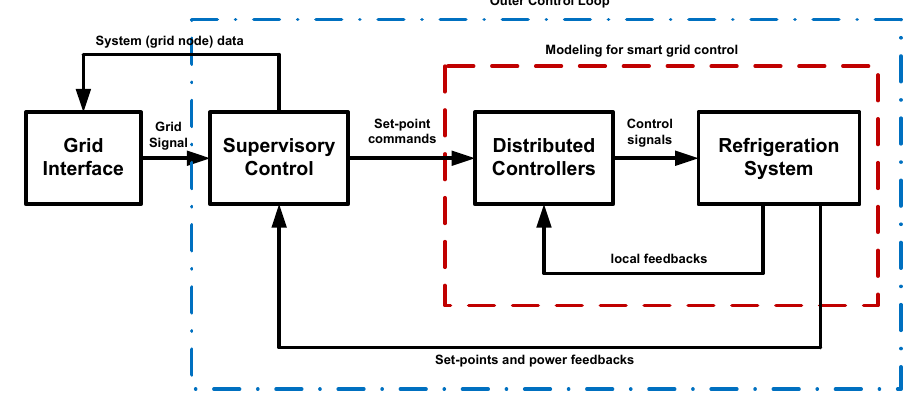
A typical control system structure for connecting supermarket refrigeration systems to the smart